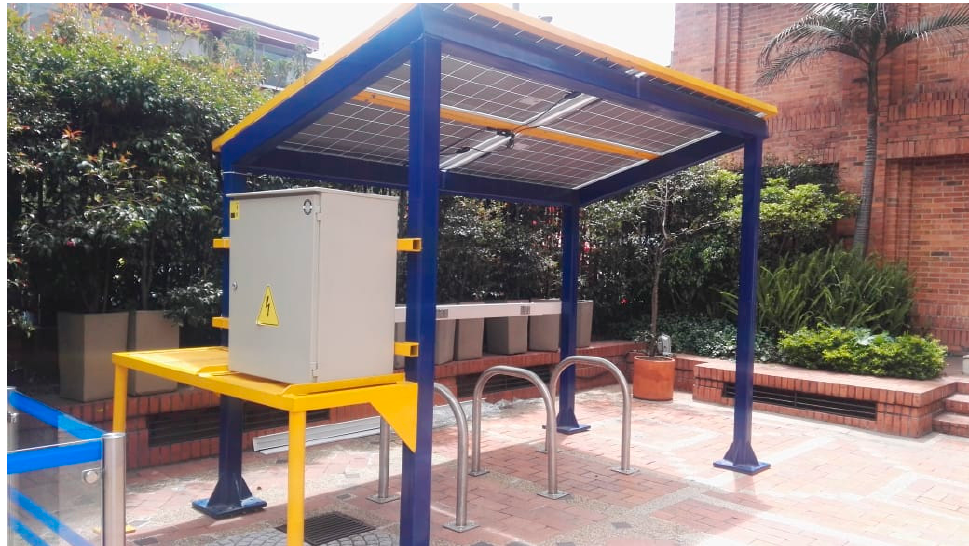
Figure 28. West BiCiSOLAR charging station.